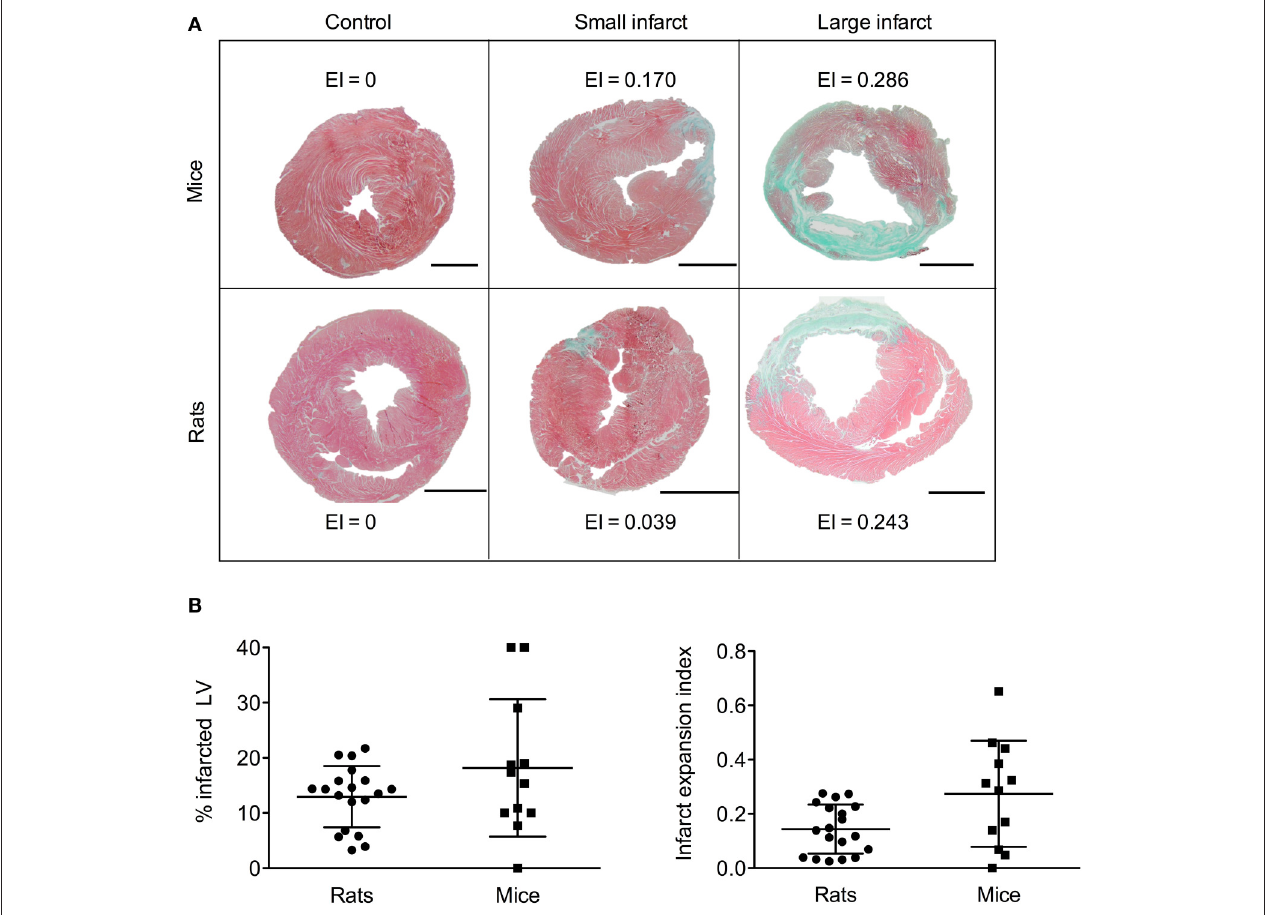
FIGURE 2 | (A) Representative sections with Masson-Goldner trichome staining showing healthy myocardia in red and fibrotic tissues in green. Scale bars indicate 1.5mm for mice and 3mm for rats. The sections were from a healthy control and LAD ligated animal, respectively. (B) Myocardial injury was assessed as the percentage of the infarcted area of the left ventricle and the infarct expansion index in mice and rats at 6 weeks post LAD ligation.